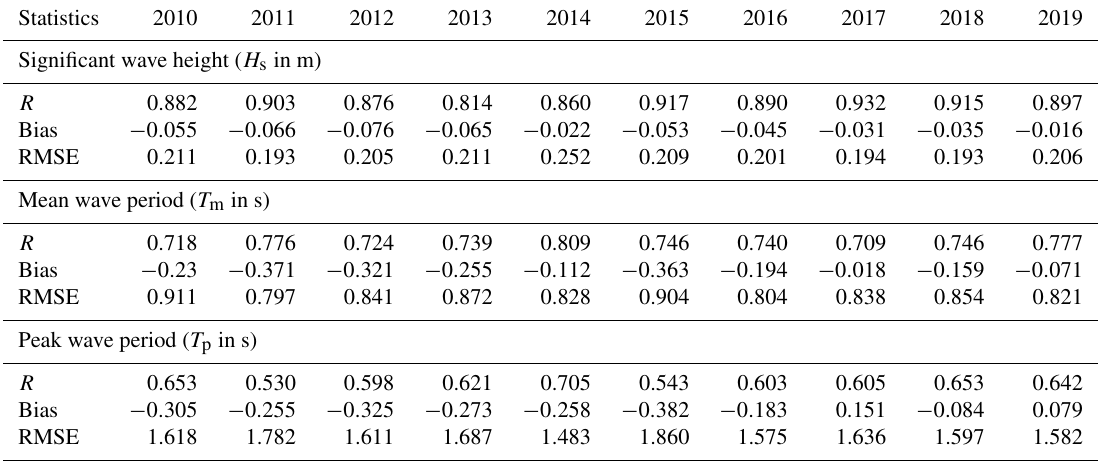
Table 4. Statistics of the comparison of buoy measurements (Cesenatico, station 6) with model results for 2010–2019.